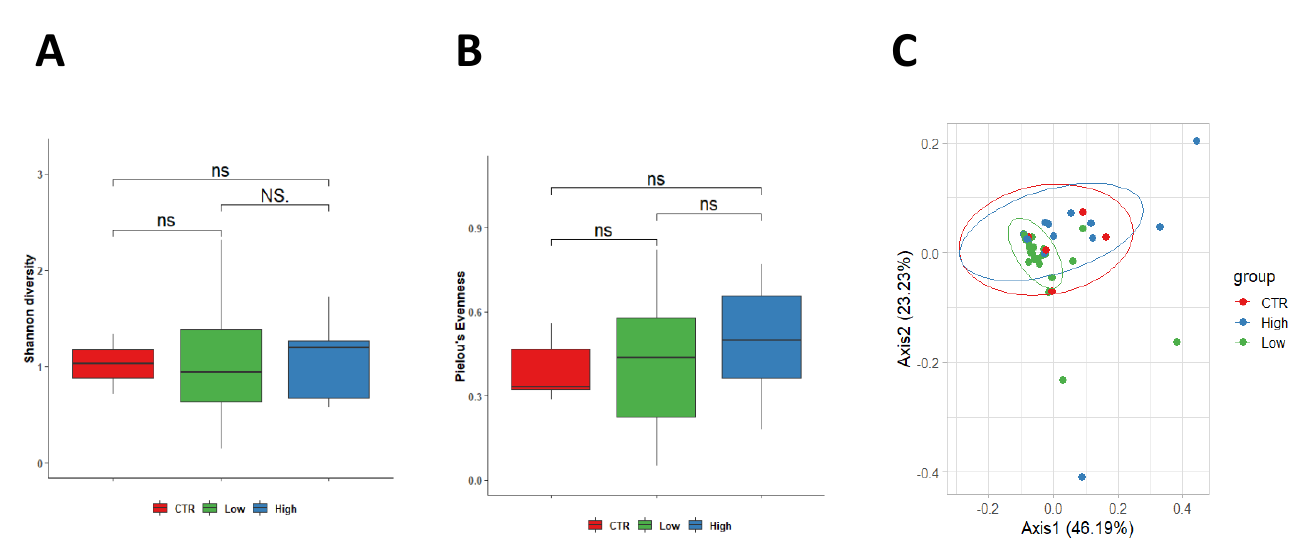
Figure 3. PERMANOVA statistical test confirmed a no significant change among the three groups ( p = 0.224, R 2 = 0.056) in vaginal samples. Legend: CTR = control; Low = Low-risk for CD; High: High-risk for CD.